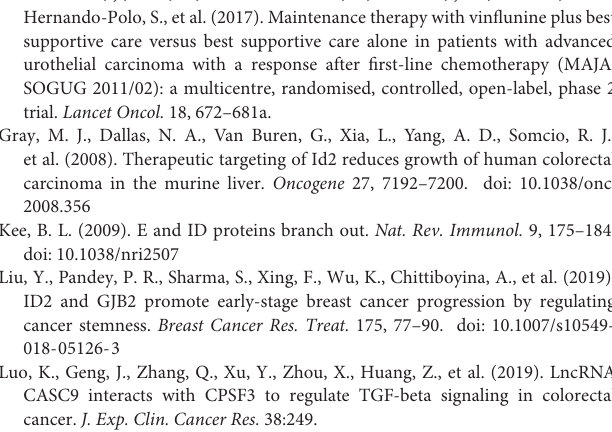
Supplementary Table 1 | Antibodies list. Supplementary Table 2 | RNA sequencing data. Supplementary Table 3 | GO analysis and KEGG analysis